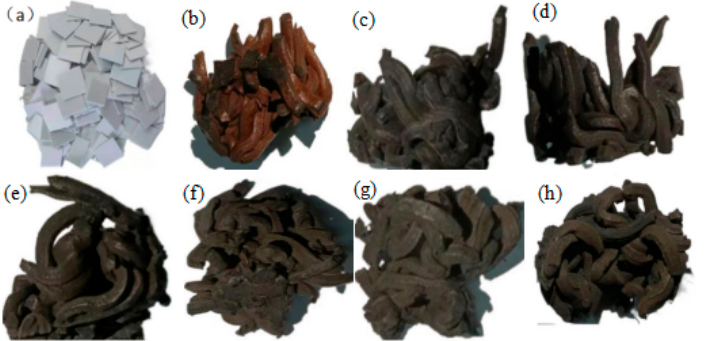
Figure 2. Morphology of PVC film heated at different temperatures: ( a ) PVC film pieces, ( b ) 280 °C, ( c ) 310 °C, ( d ) 340 °C, ( e ) 370 °C, ( f ) 400 °C, ( g ) 430 °C, ( h ) 460 °C.